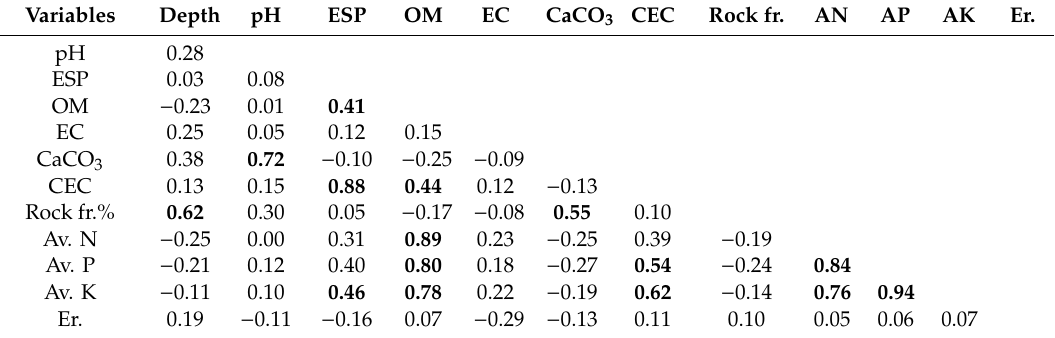
Table 3. Correlation matrix